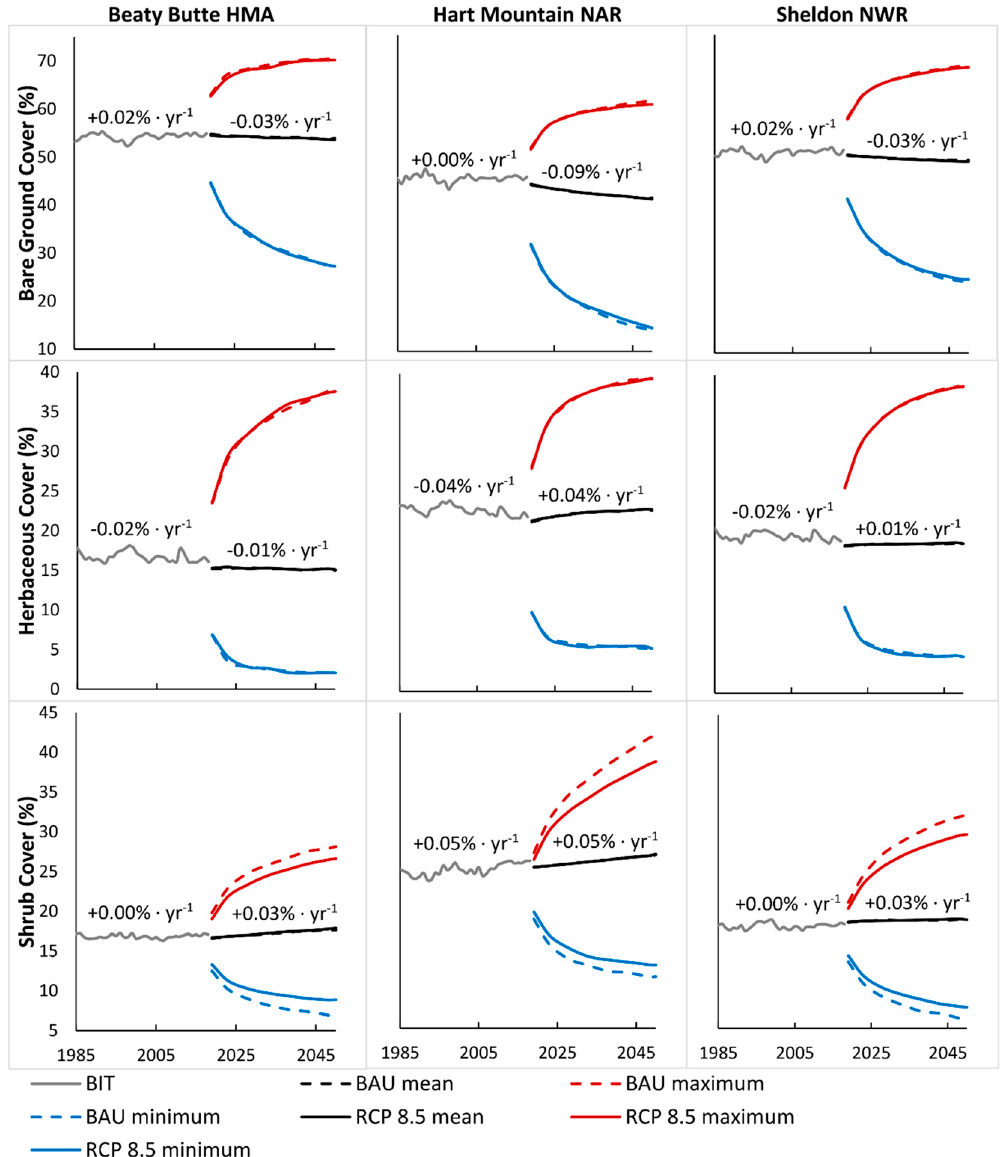
Figure 6. Mean fractional cover by management unit and scenario. For the Business as Usual (BAU) and RCP 8.5 projections, the minimum, mean, and maximum values across the 30 Monte Carlo simulations are provided. Linear slope rate for the BIT and projections are labeled above each mean trend line. RCP 8.5 mean overlaps the BAU mean.